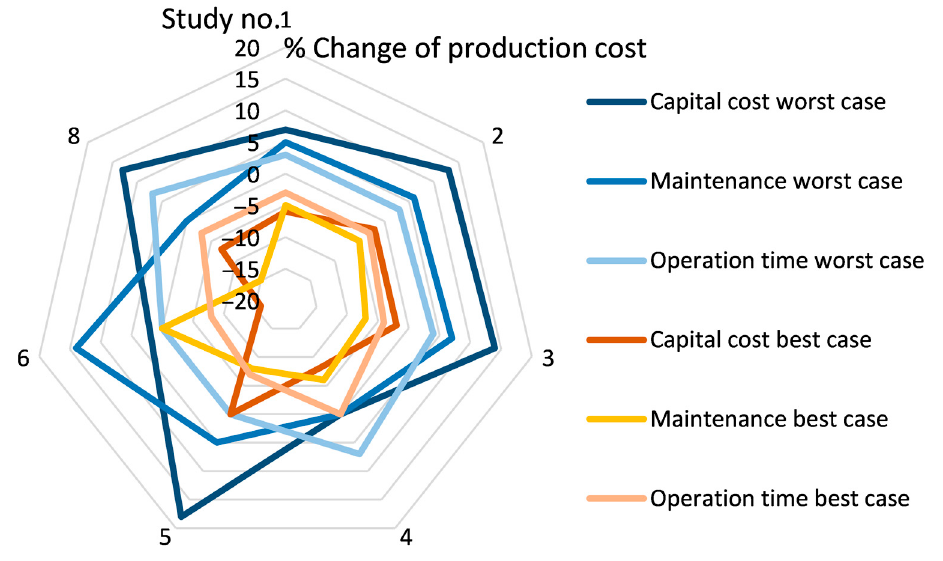
Figure 8. Changes of production cost in percentages by worst- and best-case adjustments of shares for capital cost and maintenance and of operation time.